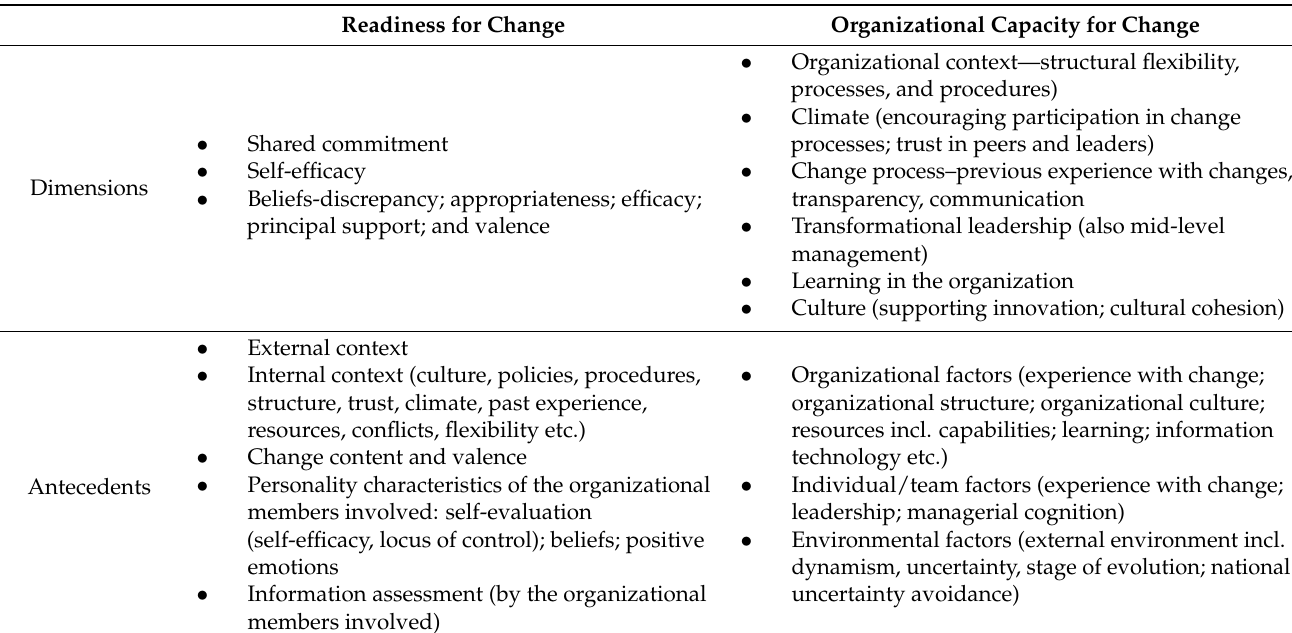
Table 2. Dimensions and